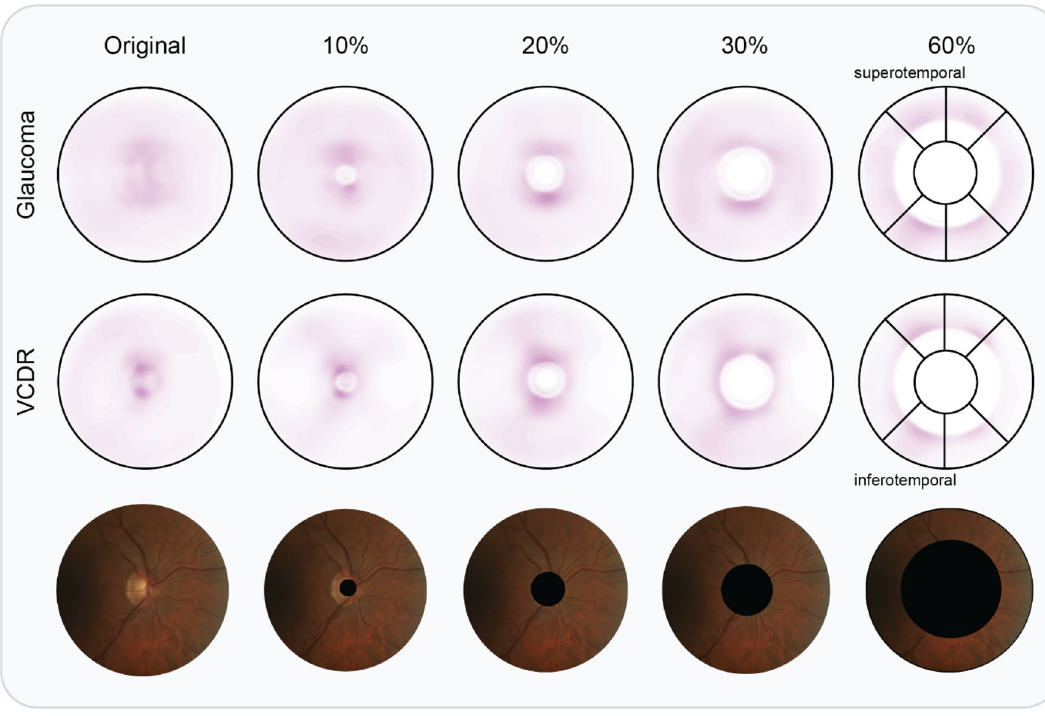
Figure 3. Averaged saliency maps for a selected number of ONH crop experiments. Top row: glaucoma detection saliency, averaged over 2643 UZL test images; middle row: VCDR regression saliency averaged over 4765 UZL test images; bottom row: a complimentary UZL fundus image of a right eye for illustrative purposes. In the last column, we draw the sectors used by glaucoma experts to locate damage. Infero- and superotemporal (bottom- and top-left, respectively) sectors are the locations most commonly damaged by